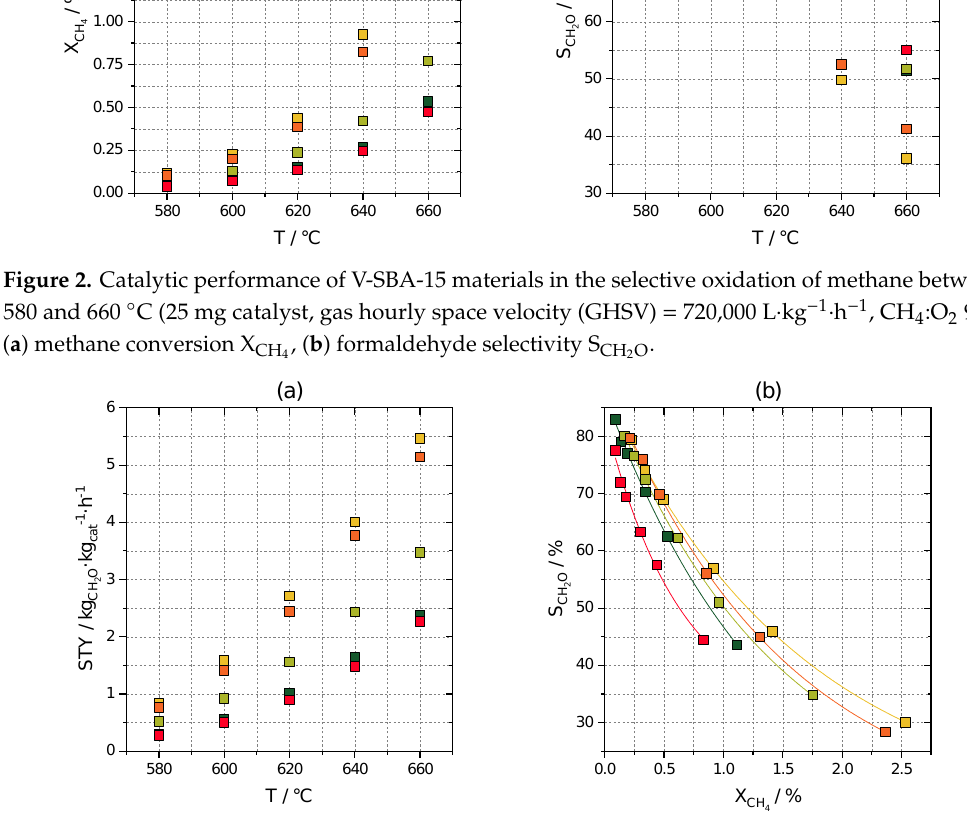
Figure 3. ( a ) Space-time yield of formaldehyde obtained by V-SBA-15 materials in the selective oxidation of methane between 580 and 660 ◦ C (25 mg catalyst, GHSV = 720,000 L · kg − 1 · h − 1 , CH 4 :O 2 9:1). ( b ) Formaldehyde selectivity vs. methane conversion recorded at 600 ◦ C (25 mg catalyst, GHSV = 720,000–120,000 L · kg − 1 · h − 1 , CH 4 :O 2